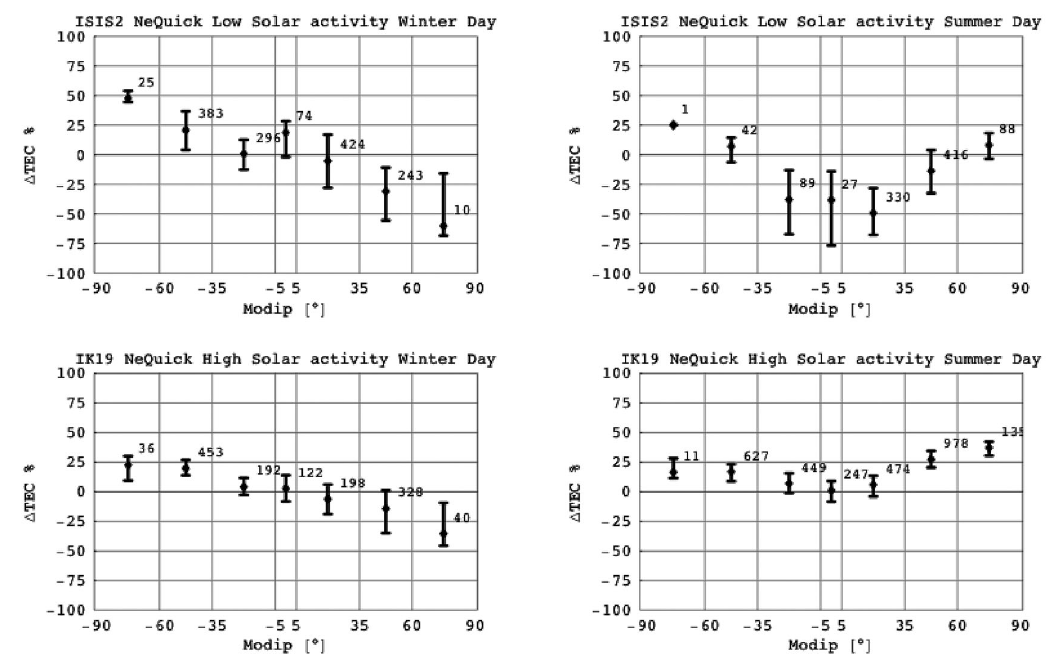
Fig. 18.13. Percent difference between experimental topside TEC and NeQuick topside TEC. Numbers indi- cate the amount of data in each